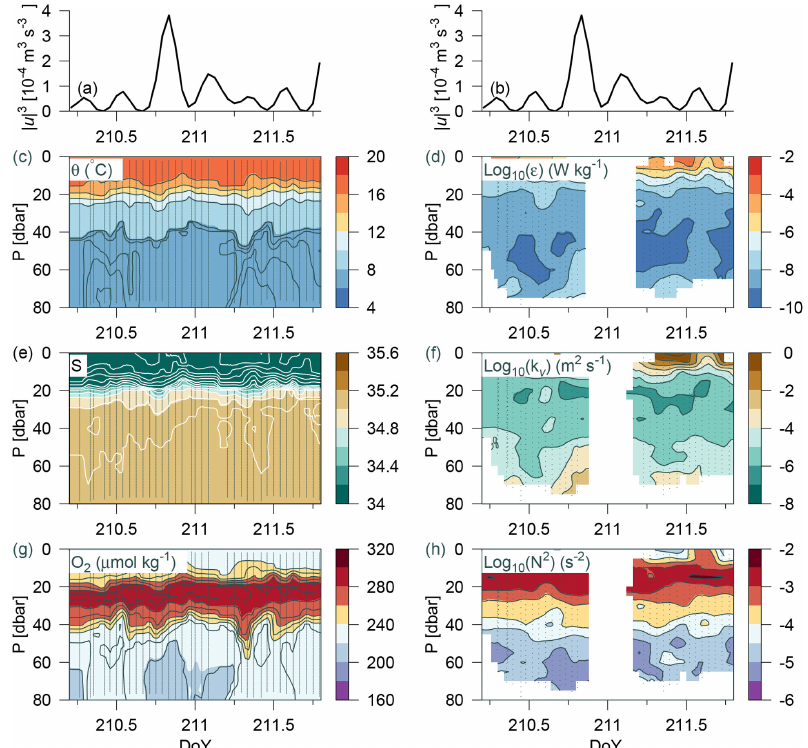
Figure 8. Time series station over 36h at the shelf edge. (a, b) Tidal current speed cubed; CTD measurements in panels (c) , (e) , (g) , and (h) of potential temperature, salinity, oxygen, and Brunt–Väisälä frequency, respectively. Turbulence measurements of (d) dissipation rate of TKE and (f) calculated vertical turbulent diffusion coefficient. Observations are shown by small grey bullets and samples for water chemistry are shown by bullets in (g)